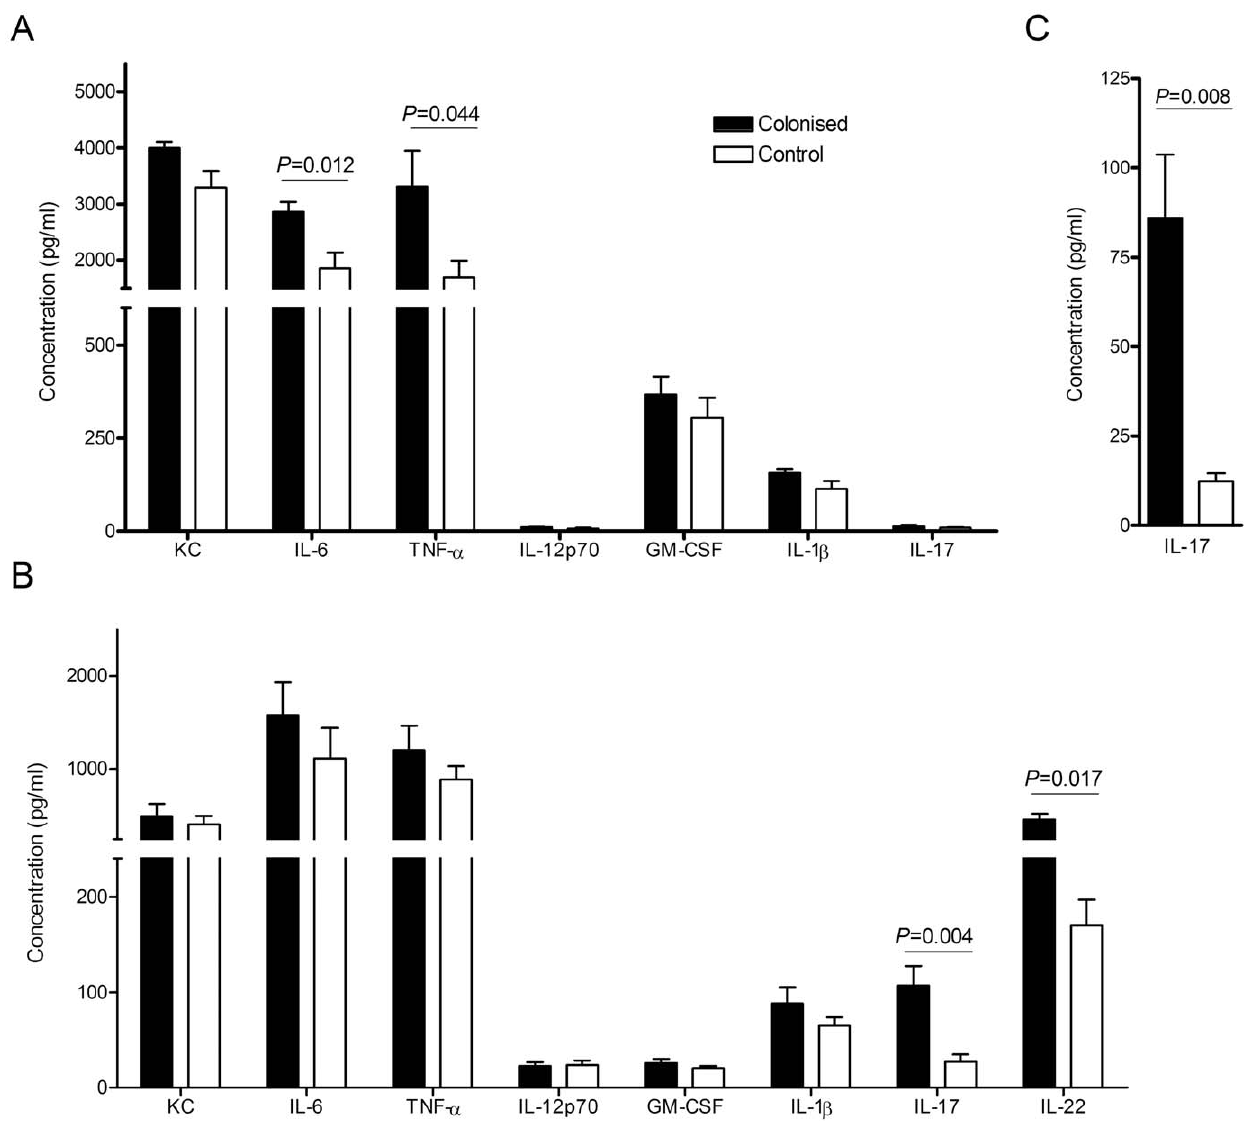
Figure 3. Effect of prior colonisation on cytokine levels during subsequent pneumonia. BALF samples were collected at either (A) 4 h or (B) 18 h and serum (C) at 18 h following pneumonia challenge of previously colonised (black bars) or control (white bars) CBA/Ca mice (n=6 per group). Cytokine levels were measured by either Luminex bead assay or ELISA. Group mean + SEM are displayed. Dotted line represents limit of